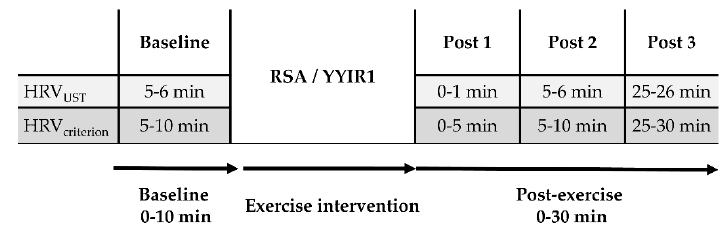
Figure 1. Schematic presentation of experimental procedure in the present study. RSA = repeated sprint ability test; YYIR1 = Yo-Yo intermittent recovery test level 1; HRV UST = ultra-short-term heart rate variability; HRV criterion = criterion of heart rate